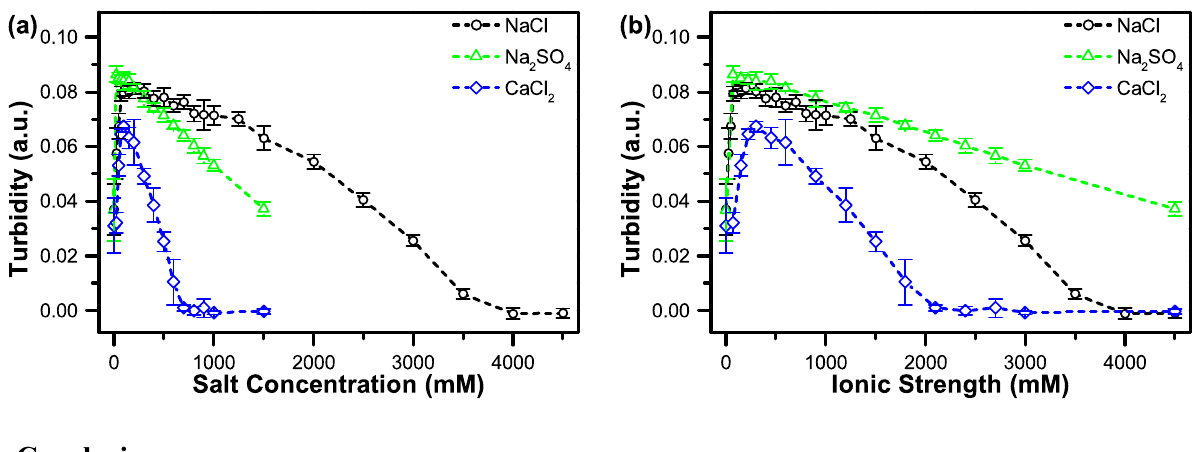
Figure 9. Plots of turbidity as a function of ( a ) salt concentration and ( b ) ionic strength for a selection of monovalent and divalent salts. All samples were prepared at 1 mM total monomer concentration, 33/67 mol% pAA/pAH ratio at pH 8.5. Complexes were prepared by adding pAA to a solution containing a mixture of pAH and the desired quantity of